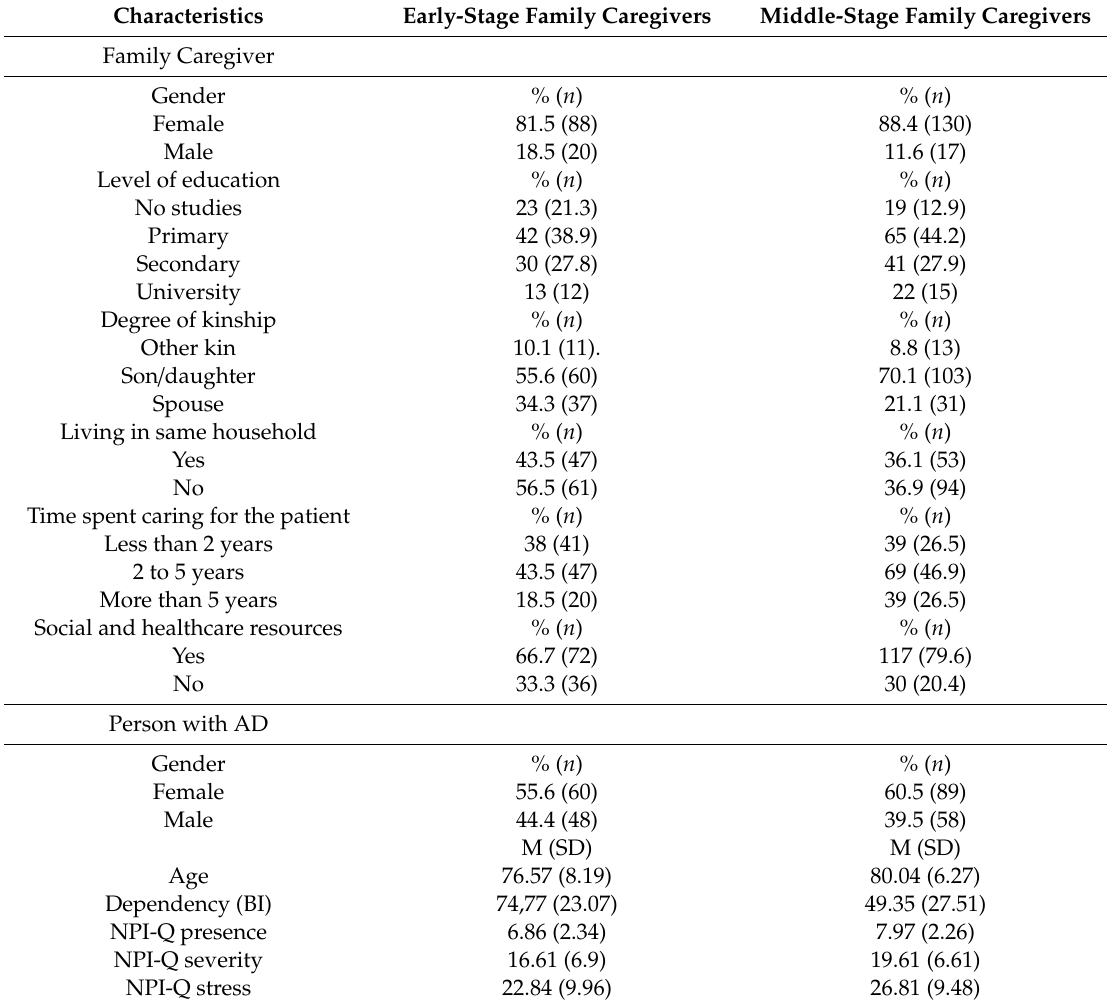
Table 1. Sociodemographic characteristics of the family caregivers and the persons with Alzheimer’s disease